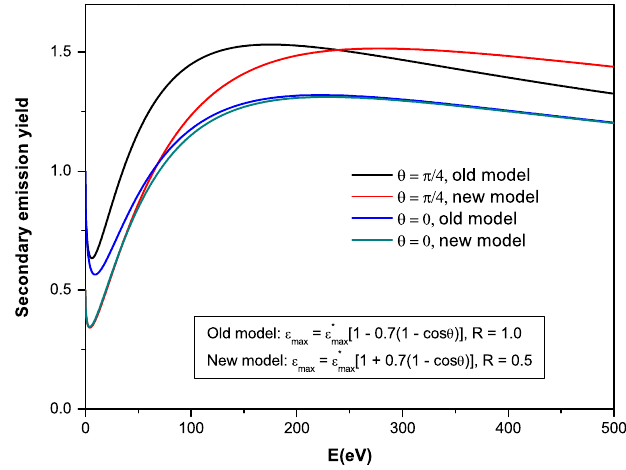
FIG. 4. Spare cooling capacity for electron cloud per meter and per beam aperture in the LHC arc as a function of bunch population. The old assumption used until 2004 [23] is compared with an updated cryogenic assessment from 2005